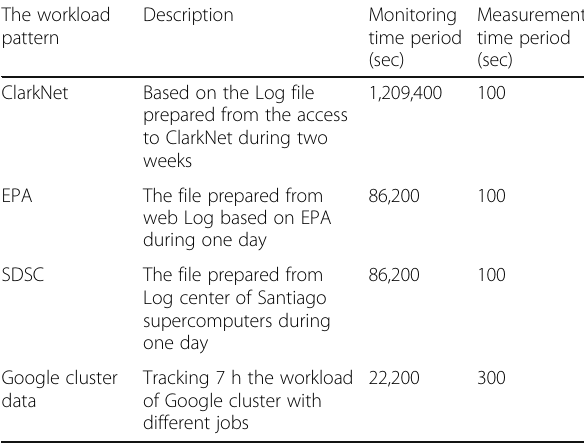
Table 1 The characteristics of used workload patterns The workload pattern